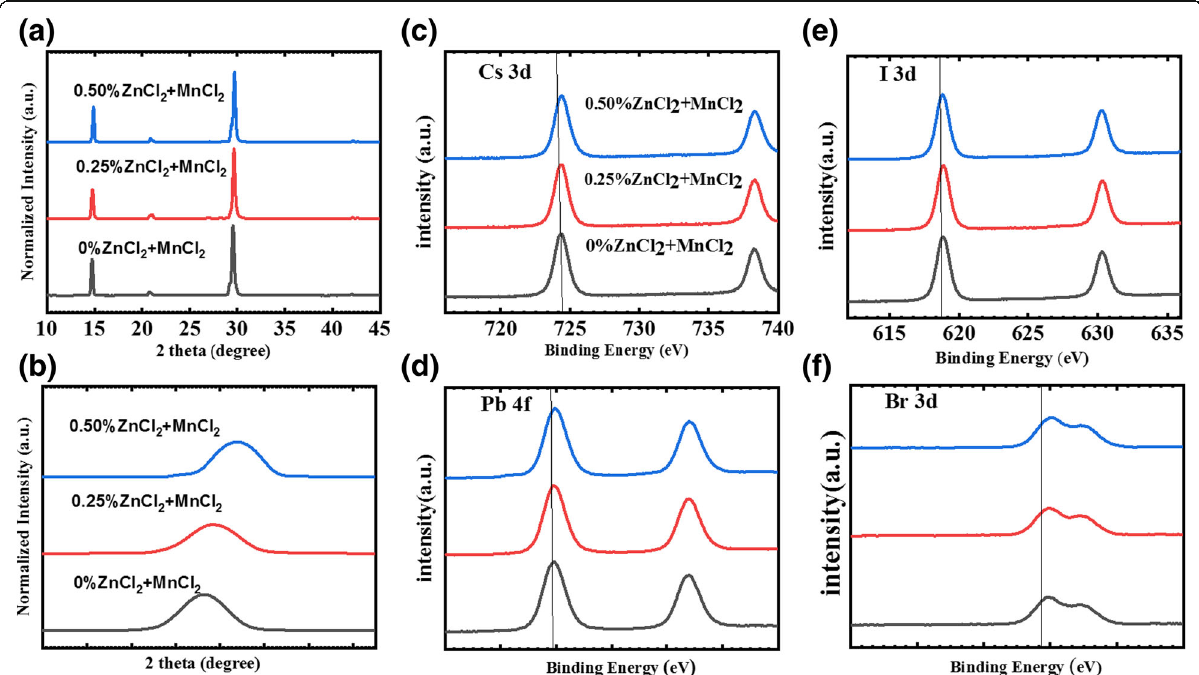
Fig. 2 X-Ray diffraction (XRD) patterns ( a ) and the enlarged region of (100) peaks ( b ) for the CsPbI 2 Br-ZnCl 2 -MnCl 2 films. XPS spectra of the CsPbI